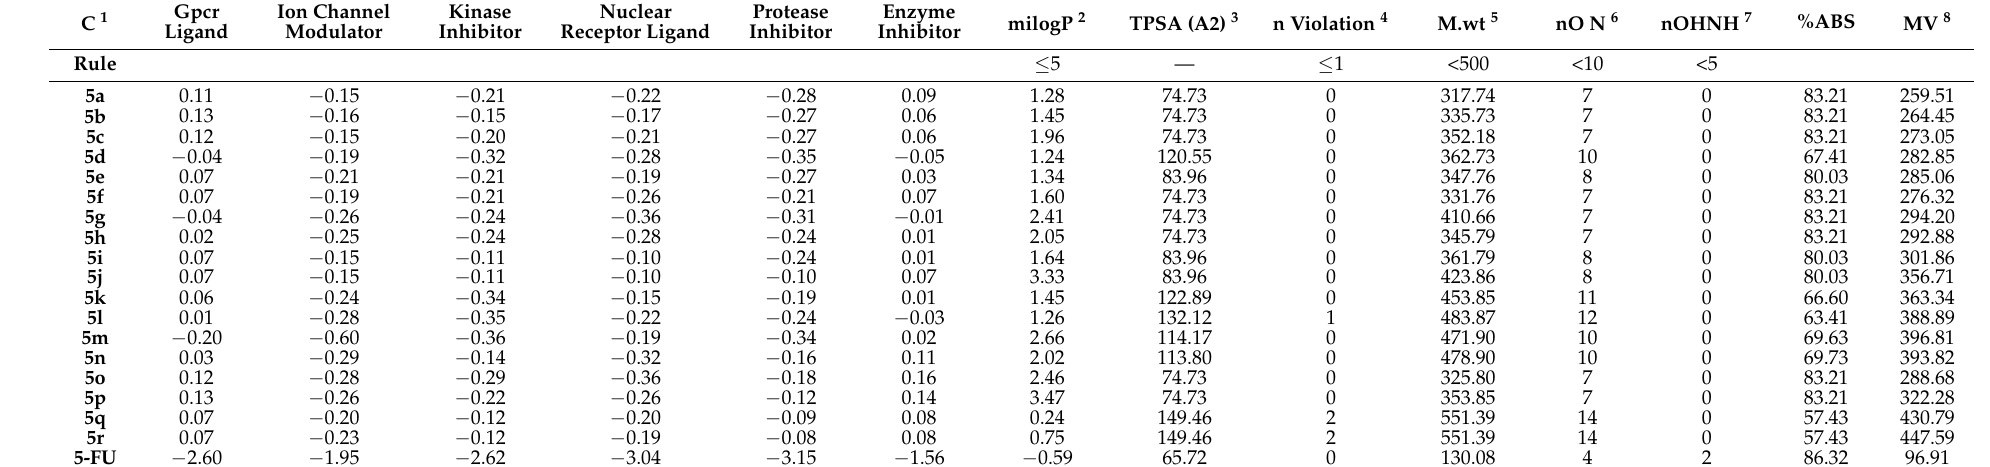
Table 2. Pharmacokinetic parameters of triazole-uracil scaffolds ( 5a – r